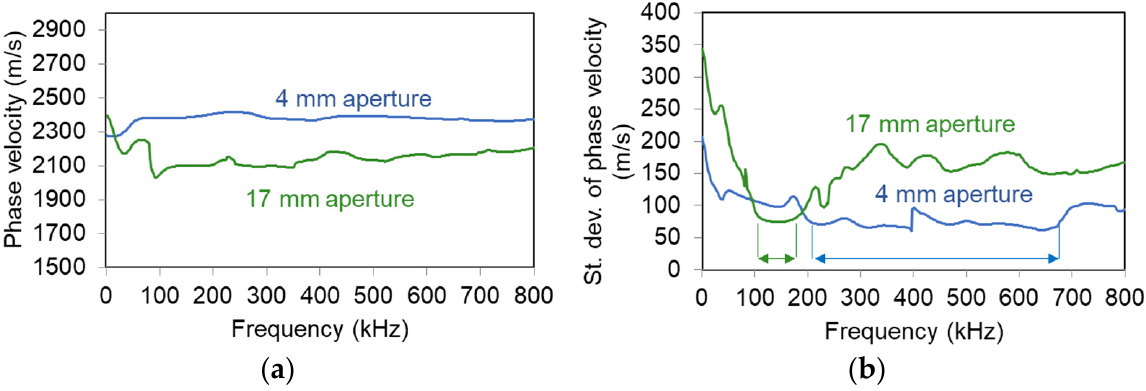
Figure 11. ( a ) Rayleigh dispersion curves on concrete surface with sensors of different apertures and ( b ) standard deviation of Rayleigh dispersion curves. The arrows indicate the band of lower stand- ard deviation.